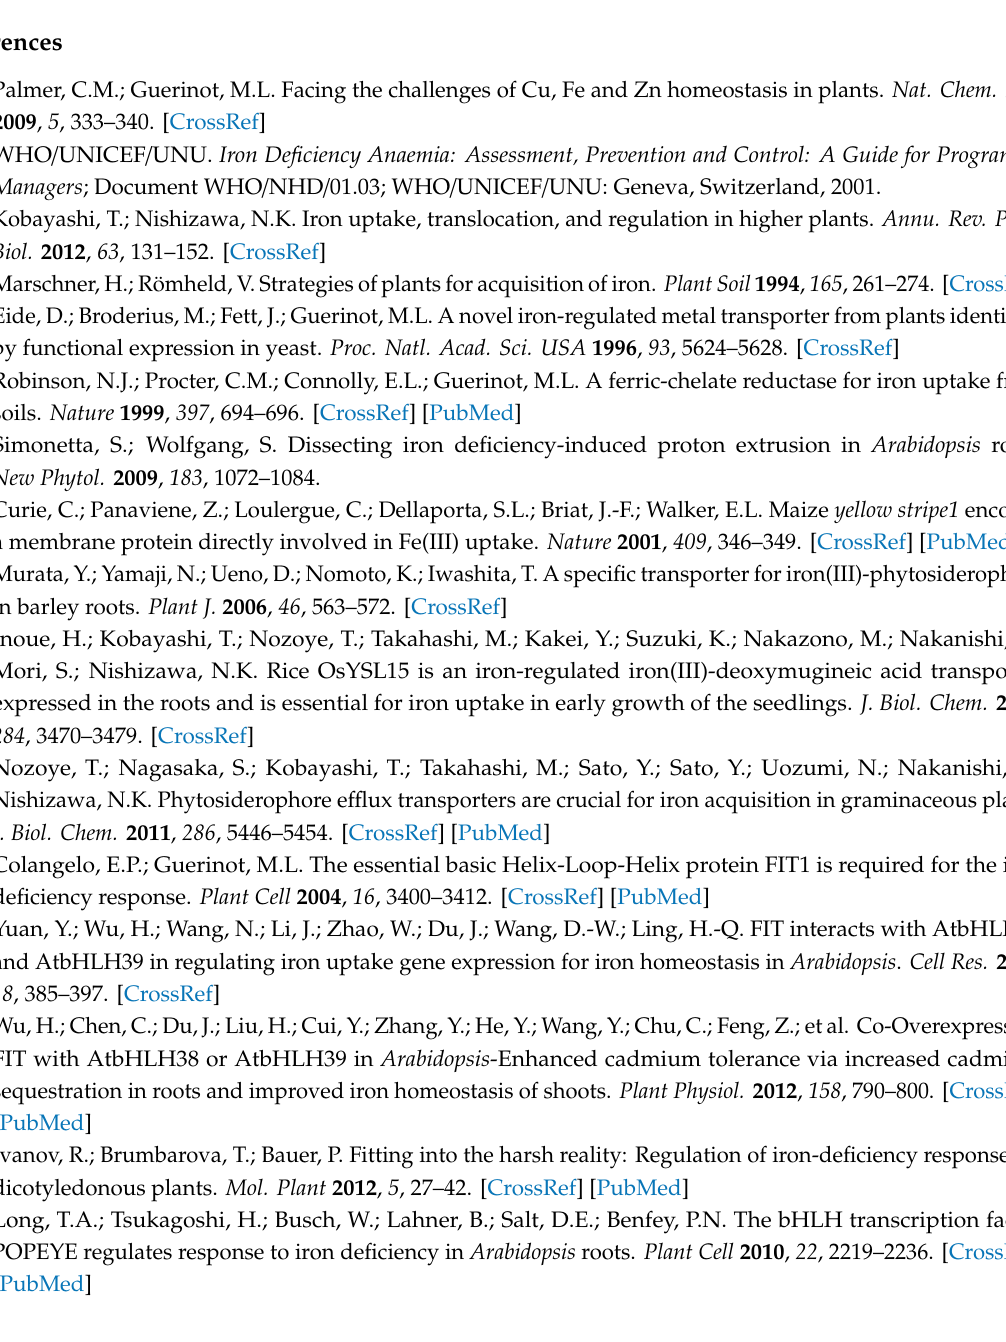
Figure S1: Gene editing of OsIRO3 . Figure S2. The predicted truncated proteins in the iro3 mutants. Figure S3. Loss of OsIRO3 function results in increased of ROS level. Figure S4. Picture of OsIRO3-GFP signal in tabaco leaves. Figure S5. Fe distribution in shoot of iro3 mutants. Figure S6. Metal distribution in new leaves of WT and iro3-2 . Table S1: Primers used in this